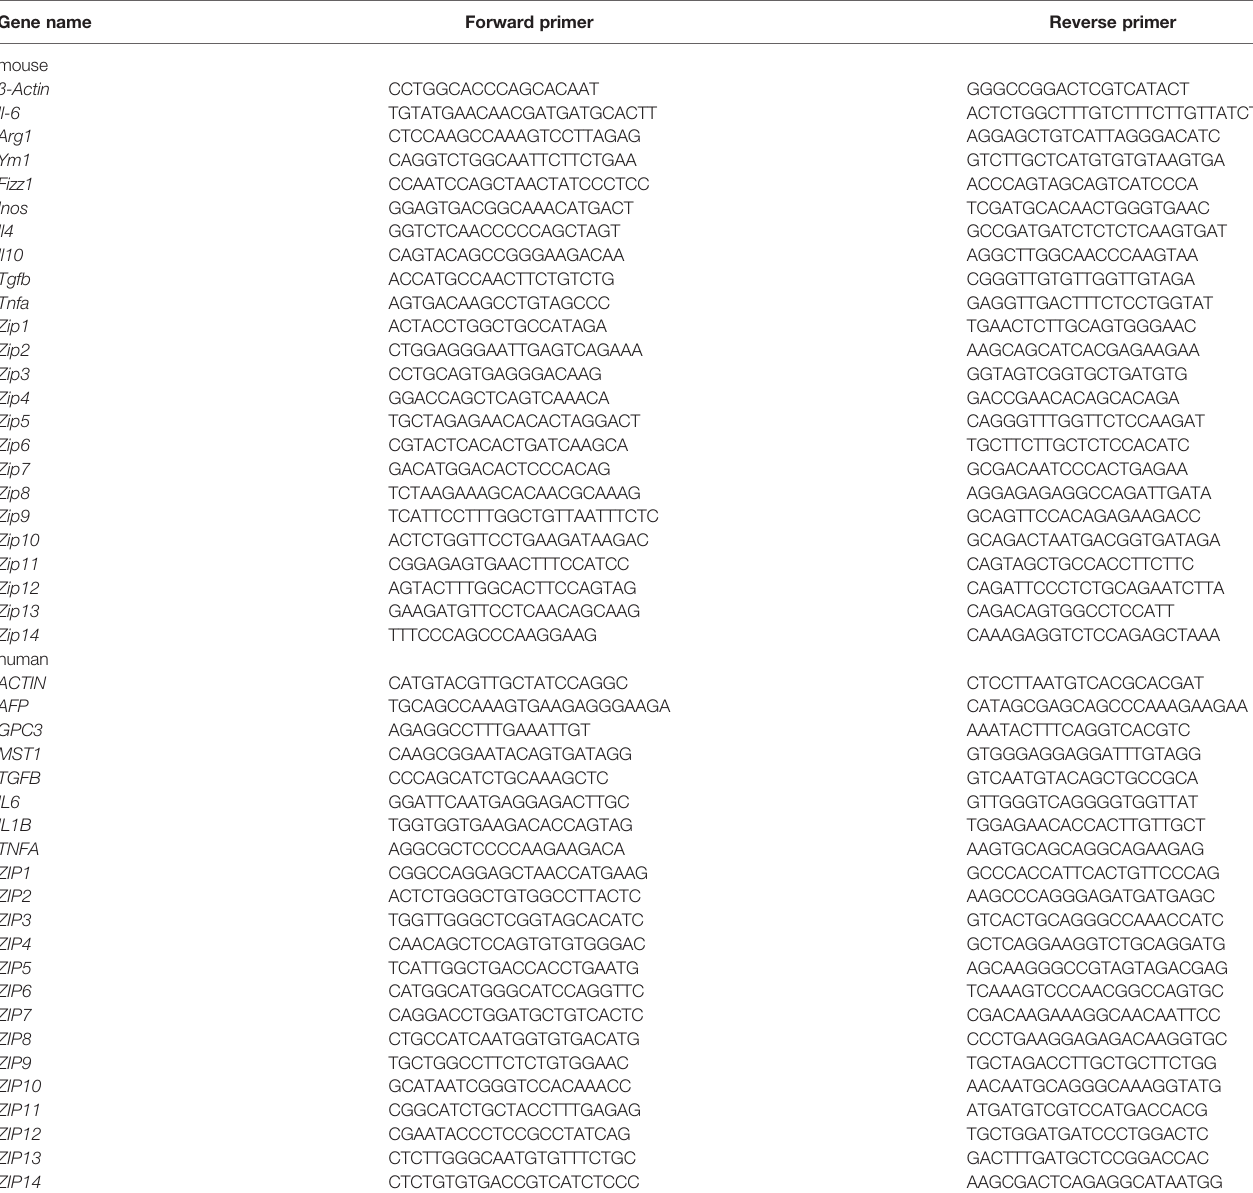
TABLE 1 | Primer sequences used for real time